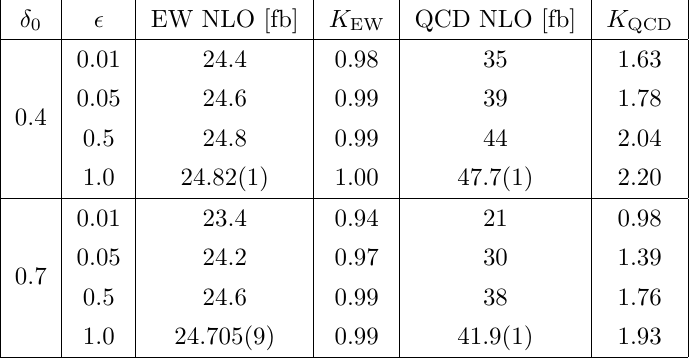
Table 2 . EW and QCD pp (cid:13)(cid:13)jj cross sections at di(cid:11)erent values of photon-isolation parameters. ! The numbers in the parentheses are the statistical errors. EW and QCD LO cross sections, being independent of those parameters, are 24 : 929(6) fb and 21 : 664(10) fb,